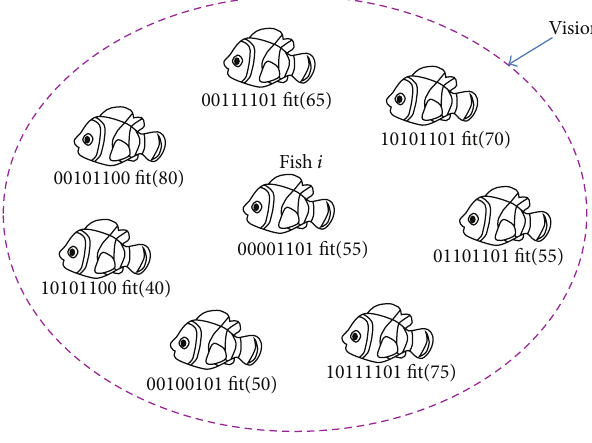
Figure 2: Initiation step of